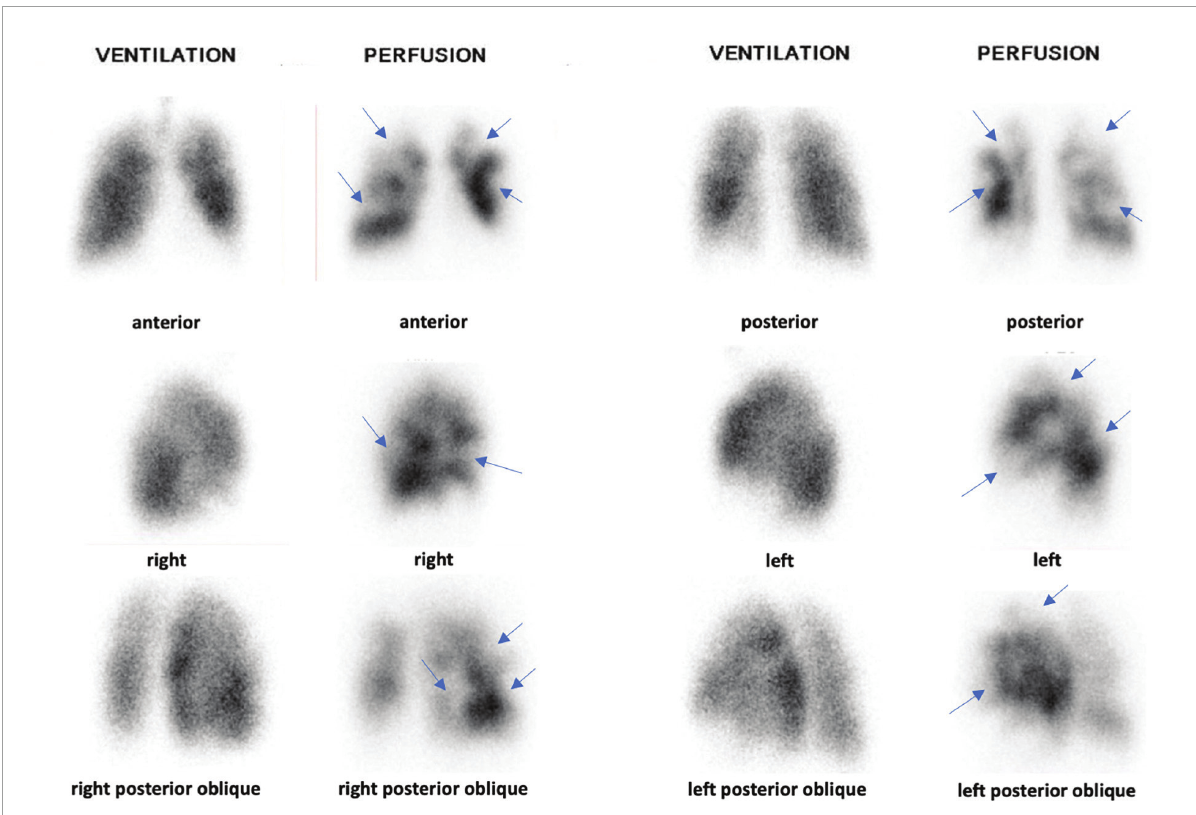
FIGURE3 Planar V/Q lung scintigraphy with multiple mismatched perfusion defects (blue arrows). Based on Meyer score, PVOI was estimated at 50%. Right Upper Lobe (RUL): 0.5 × 18% = 9%. Middle Lobe (ML): 0.5 × 12% = 6%. Right Lower Lobe (RLL): 0.5 × 25% = 12.5%. Left Upper Lobe (LUL): 0.5 × 13% = 6.5%. Lingula: 0.5 × 12% = 6%. Left Lower Lobe (LLL): 0.5 × 20% = 10%. PVOI = 100 – (RUL + ML + RLL + LUL + LLL + Lingula) = 50%. Based on SVS method, PVOI was estimated at 45%: 9 sub-segmental mismatched perfusion defects: 9 × 5 =